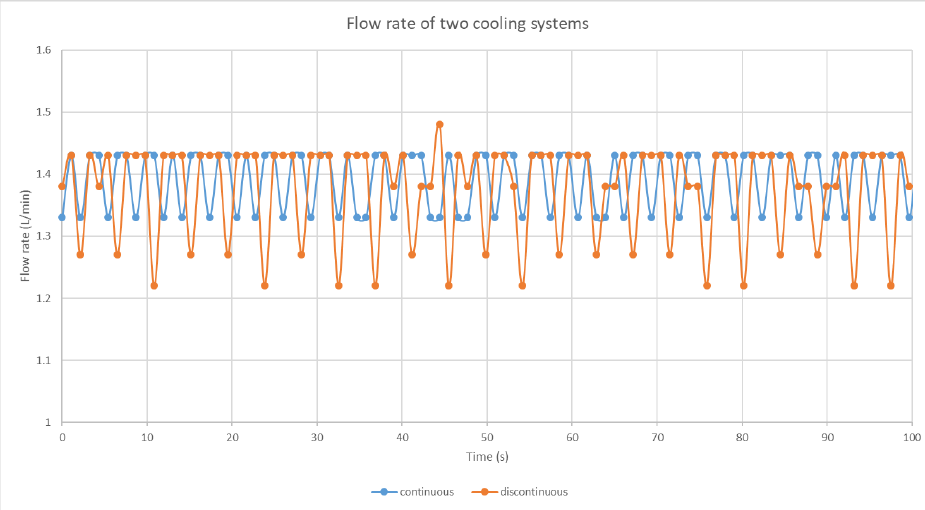
Figure 3. Flow rate of the continuous and discontinuous cooling system.